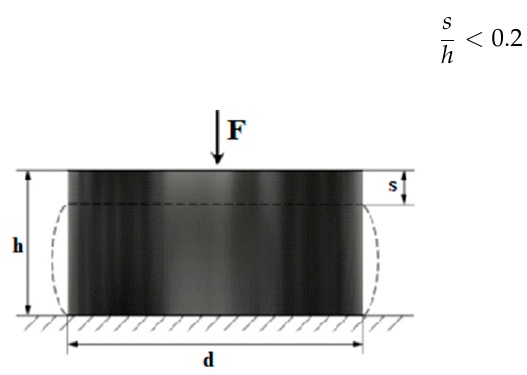
Figure 3. Scheme of tensile tests of shock absorbers.